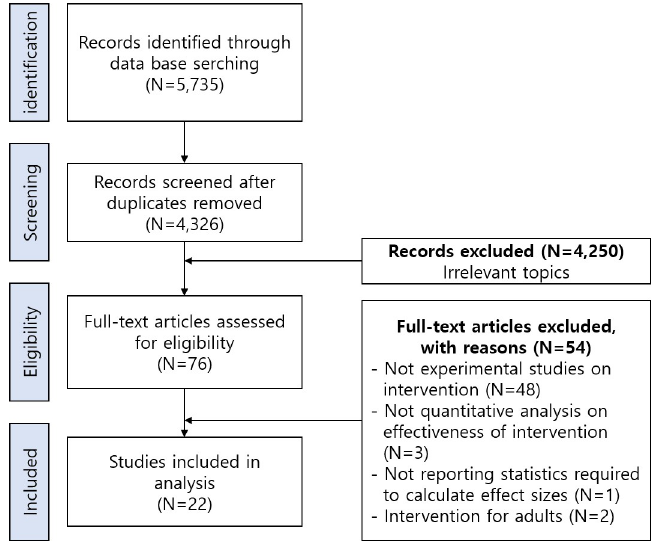
Fig 1. PRISMA flowchart for data